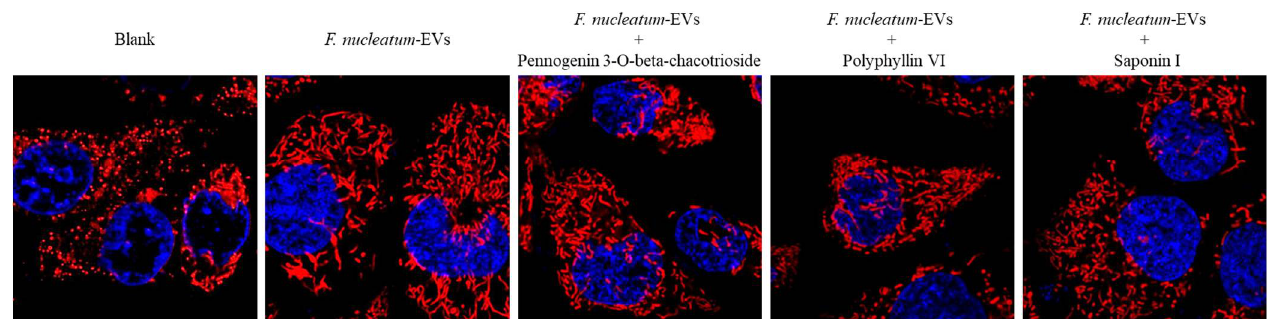
Figure 7. Mitochondria morphology of Caco-2 cells after treating with F. nucleatum -derived EVs (1 × 10 8 particles/mL) for 36 h with or without pennogenin 3- O -beta-chacotrioside, polyphyllin VI, and saponin I at 1 μM.